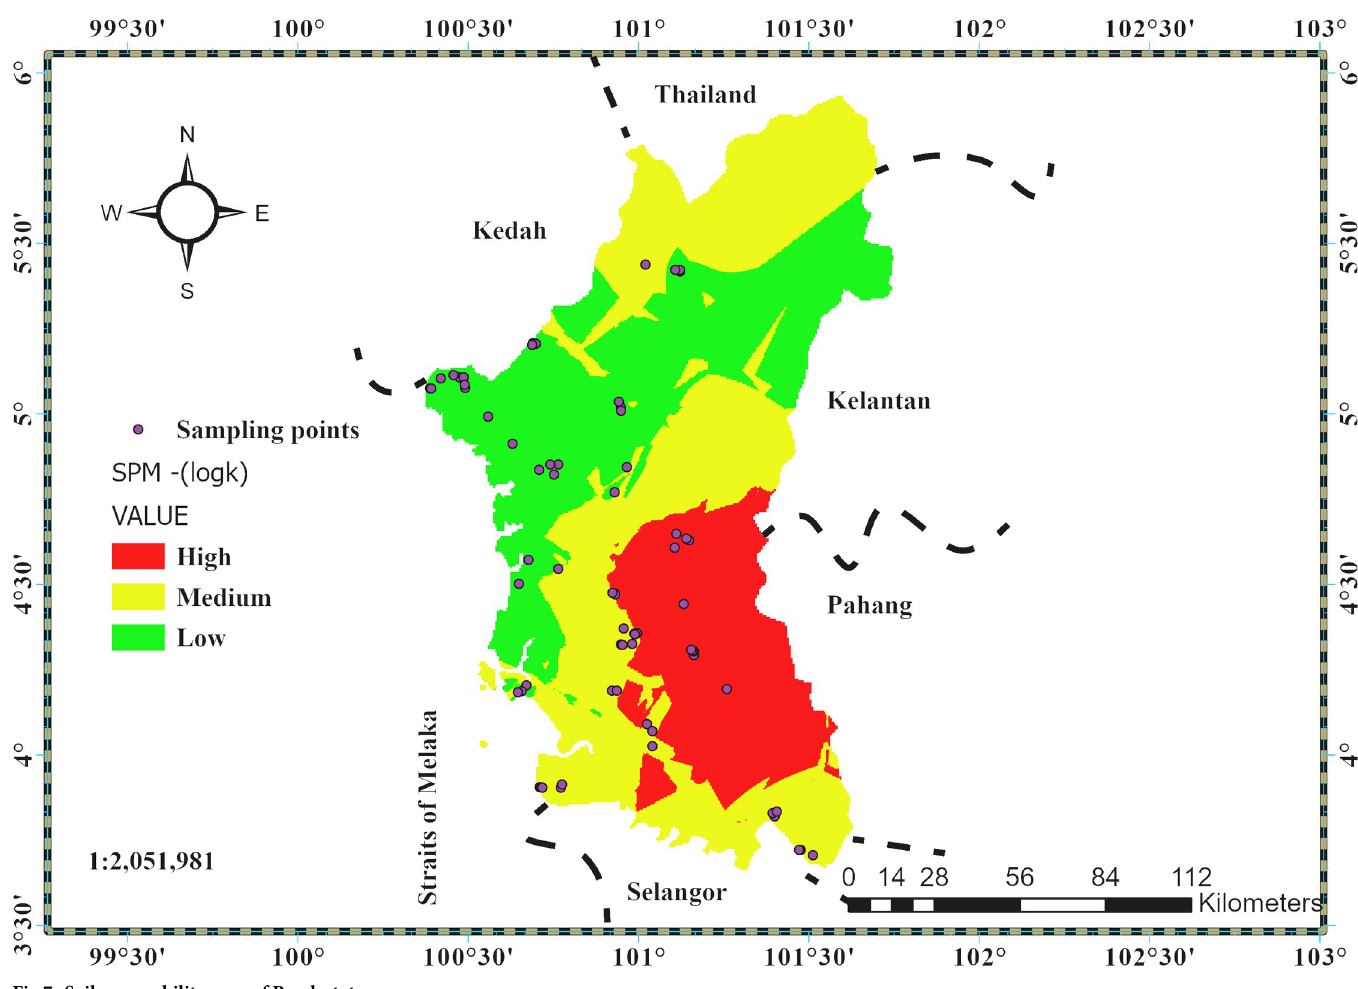
Fig 7. Soil permeability map of Perak